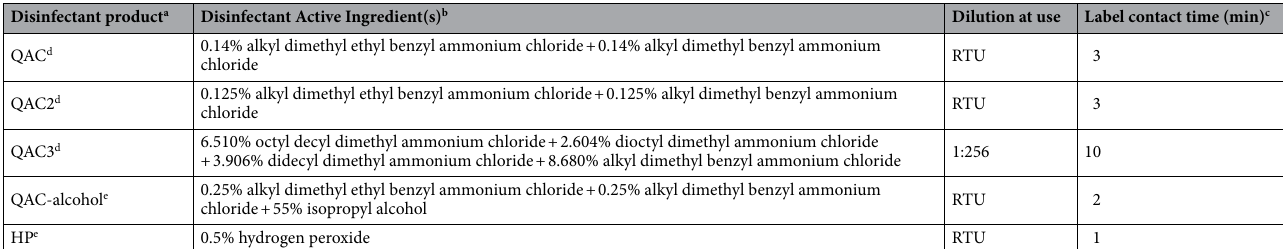
Table 1. Active ingredients, dilution at use, and label contact time of disinfectant products used in the study. a Abbreviated naming scheme for commercially available EPA registered disinfectant products used in this study; b Active ingredients concentration; c Defined label contact time for standard use; d EPA registered disinfectant with no claims against C. auris ; e EPA registered disinfectant with claim against C.